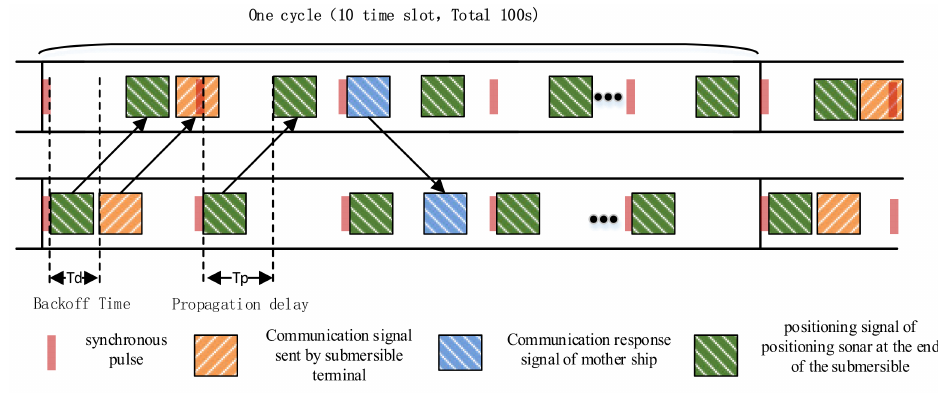
Figure 14. Schematic diagram of synchronous